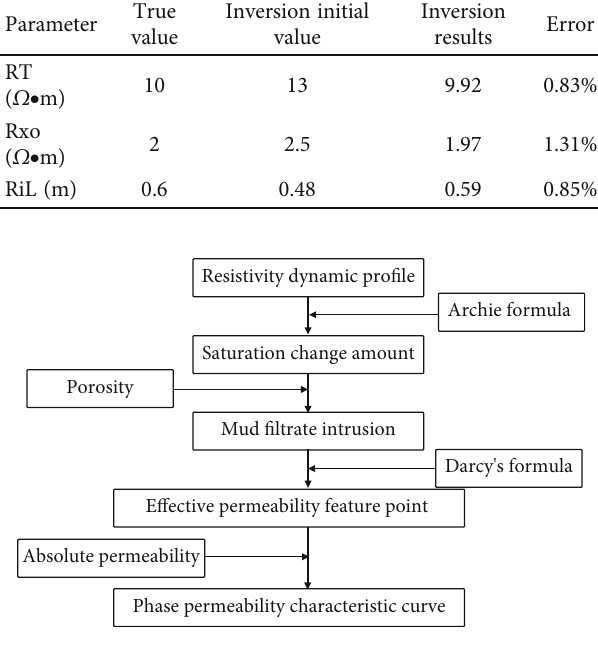
Figure 7: Flow chart of the construction of the phase permeability characteristic